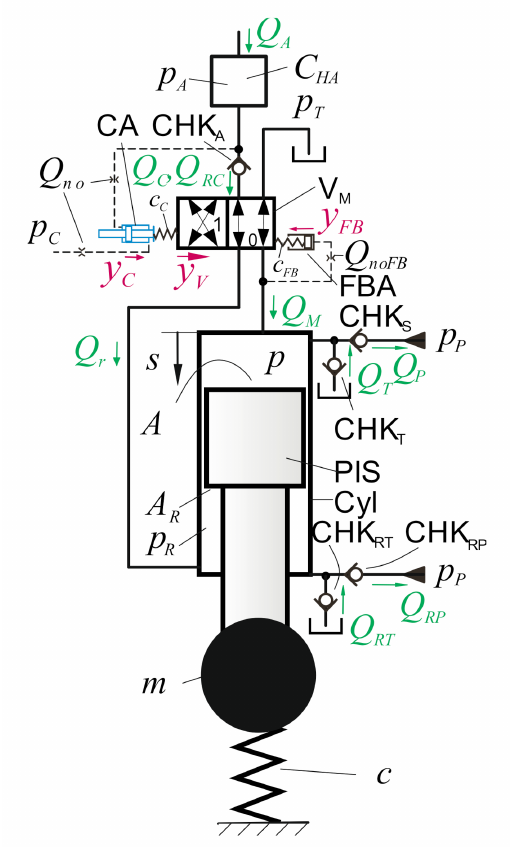
Figure 6. The hydraulically controlled OMC for pressure